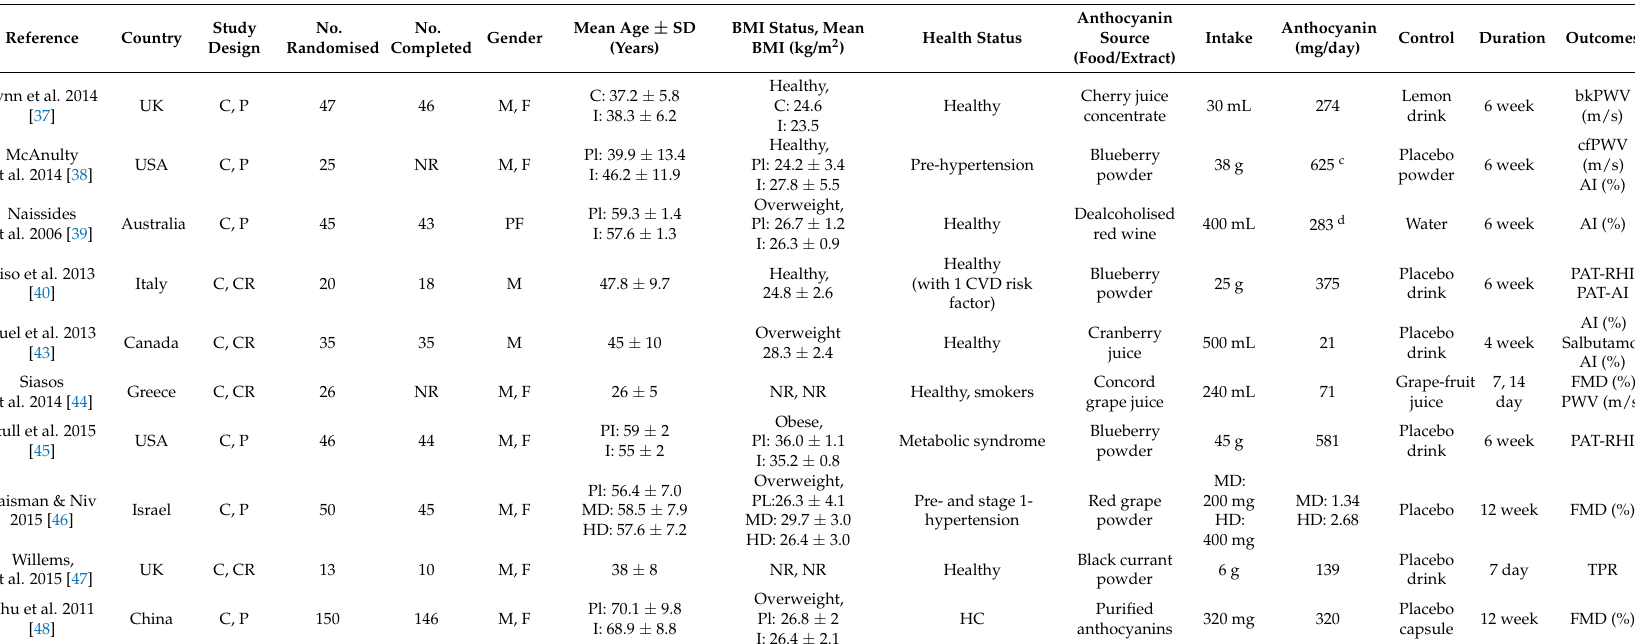
Overweight, Pl: 26.8 ± 2 I: 26.4 ±